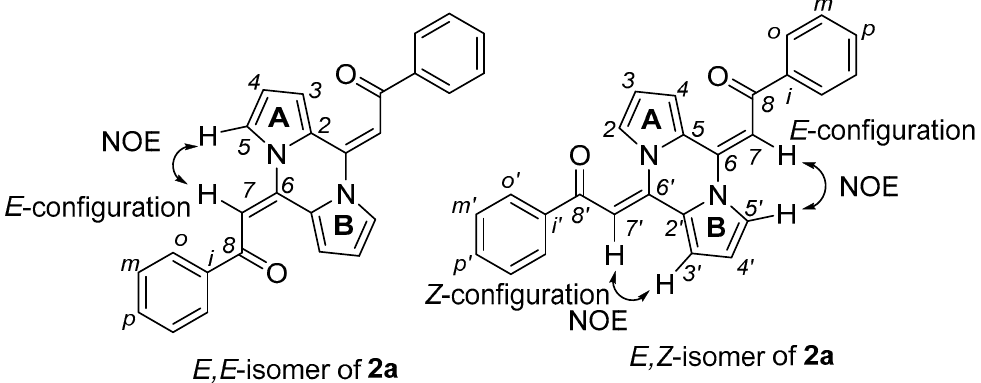
Figure 2. Atom numbering and NOESY cross-peaks of the E,E - and E,Z -isomers of the compound 2a . E,E - and E,Z -configuration of product isomers was assigned according to 2D NOESY spectrum on the example of compound 2a . The cross-peak between the H5 (7.45 ppm) and H7 (6.92 ppm) signals is observed in the 1 H- 1 H NOESY spectrum (see Supplementary Materials, Figure S3) of the E , E -isomer. In the E , Z -isomer, the cross-peak between the H5 ′ (7.45 ppm) and H7 (6.88 ppm) signals belongs to the moiety with the E -configuration, while the cross-peak between the H3 ′ (6.94 ppm) and H7 ′ (6.85 ppm) signals is attributed to the moiety with the Z -configuration (Figure 2).